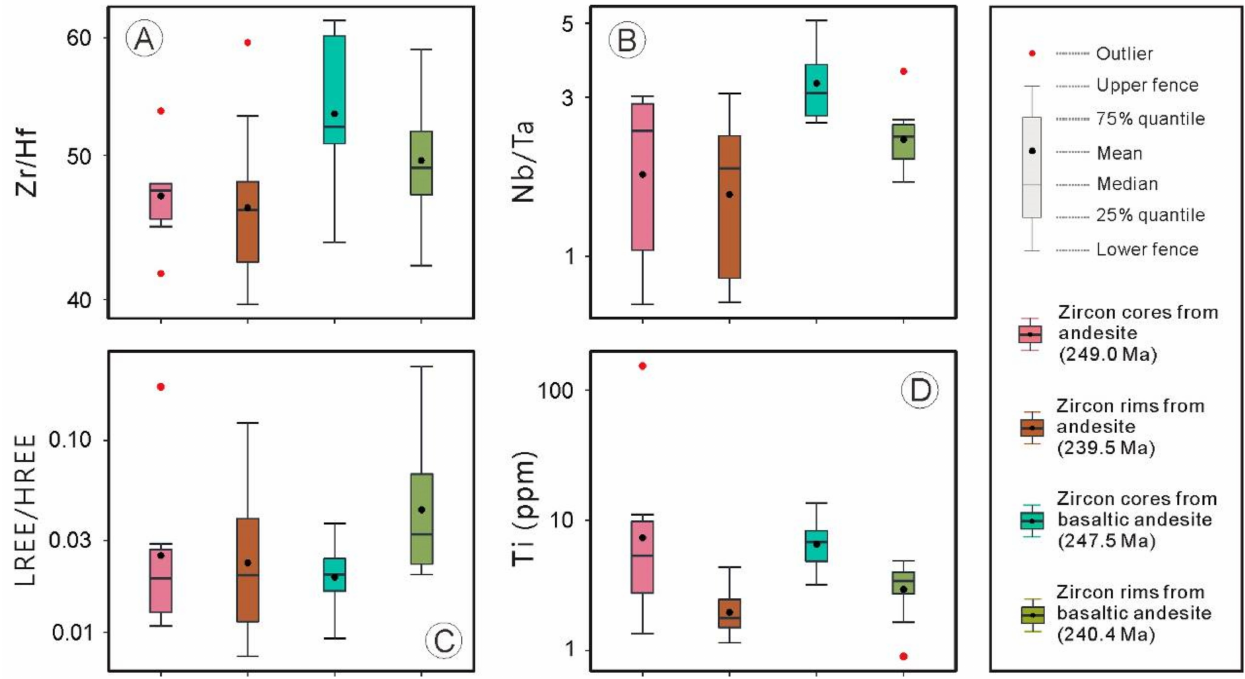
Figure 4. Boxplots of zircon ( A ) Zr/Hf, ( B ) Nb/Ta, ( C ) LREE/HREE ratios, and ( D ) Ti content for the Nageng andesite and basaltic